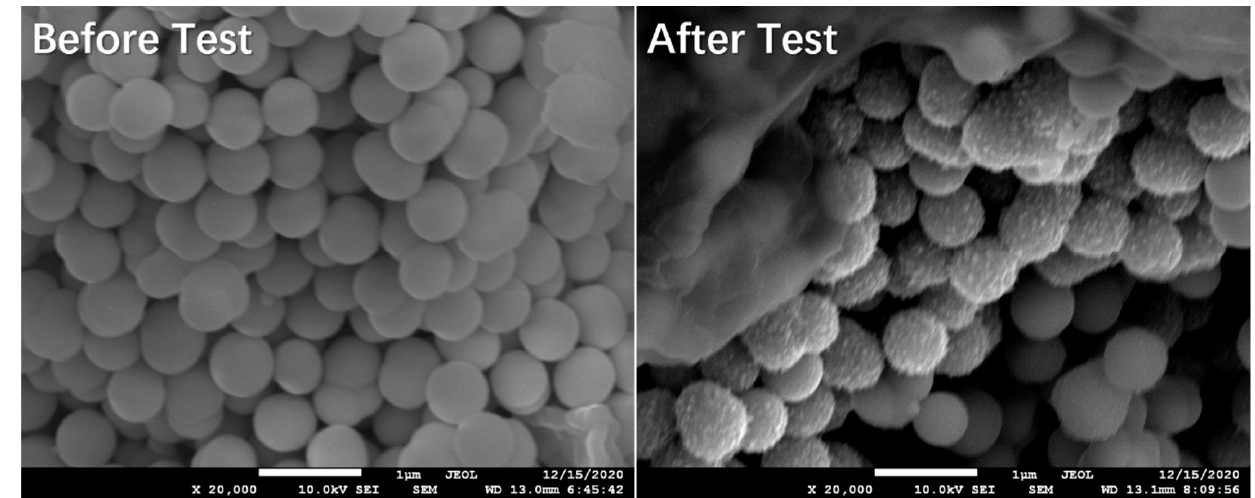
Figure 9. Surface morphology of P-1:3 sample before/after test.